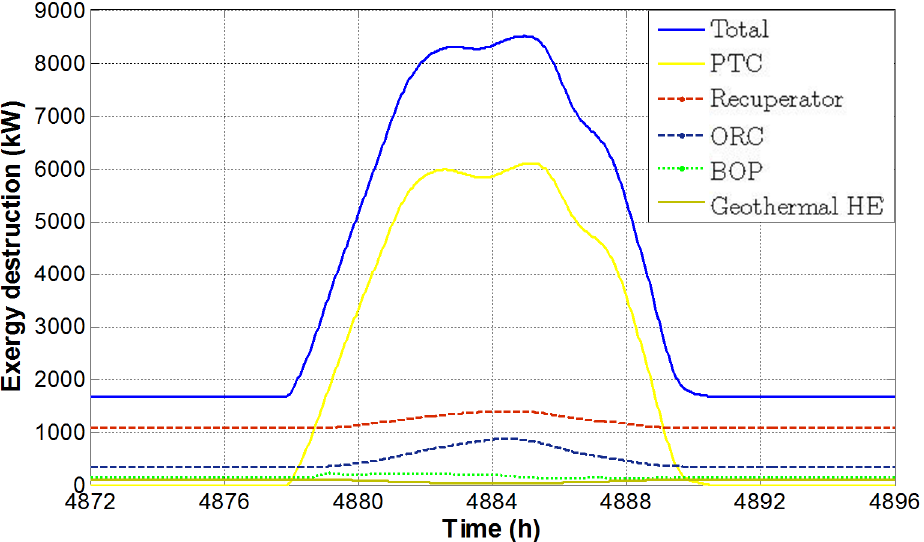
Figure 8. Exergy destructions in a summer